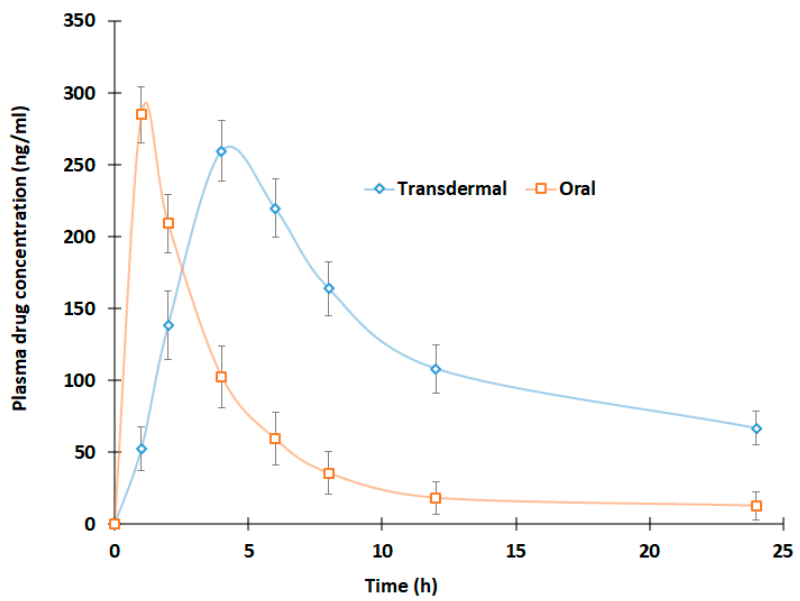
Figure 12. Plasma concentration-time plot of treprostinil from optimized patch and control (oral) ( n = 6). Table 7. In vivo parameters of treprostinil in plasma after oral and transdermal delivery in rats. Parameters